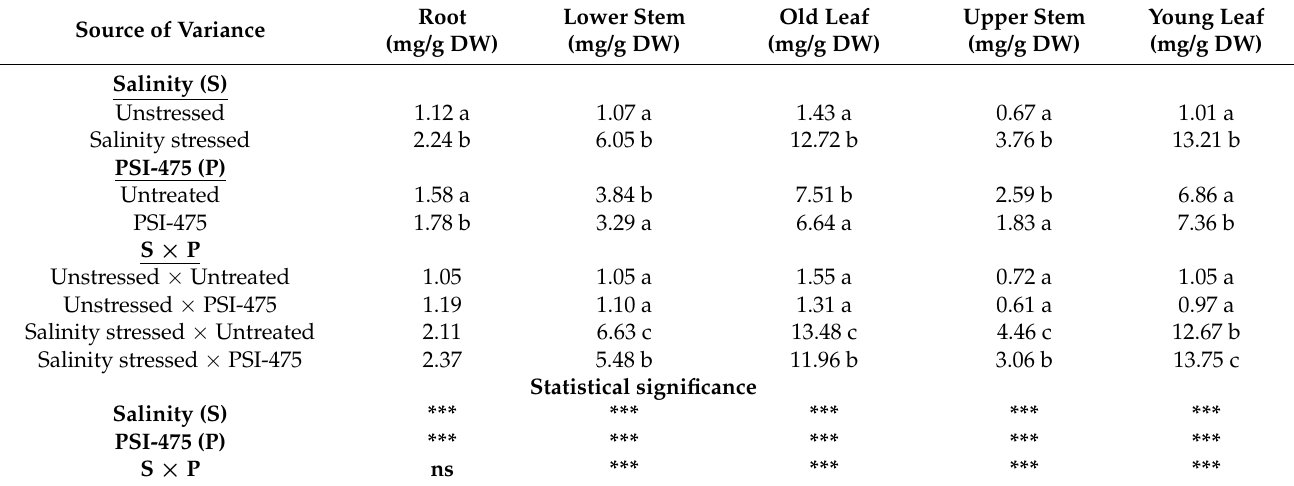
Table 4. Effect of salinity stress and PSI-475 on proline content in different tomato plant tissues.